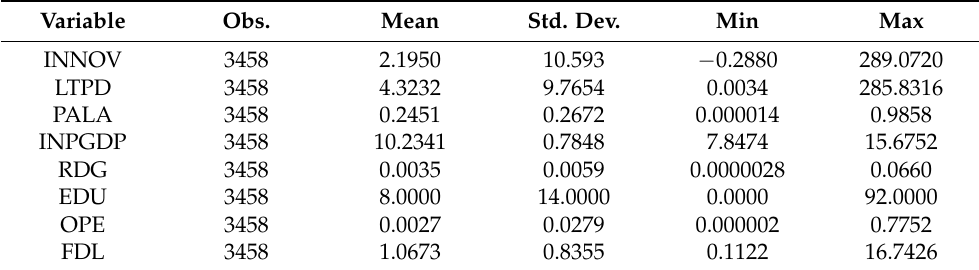
Table 2. Descriptive statistics of the variables.